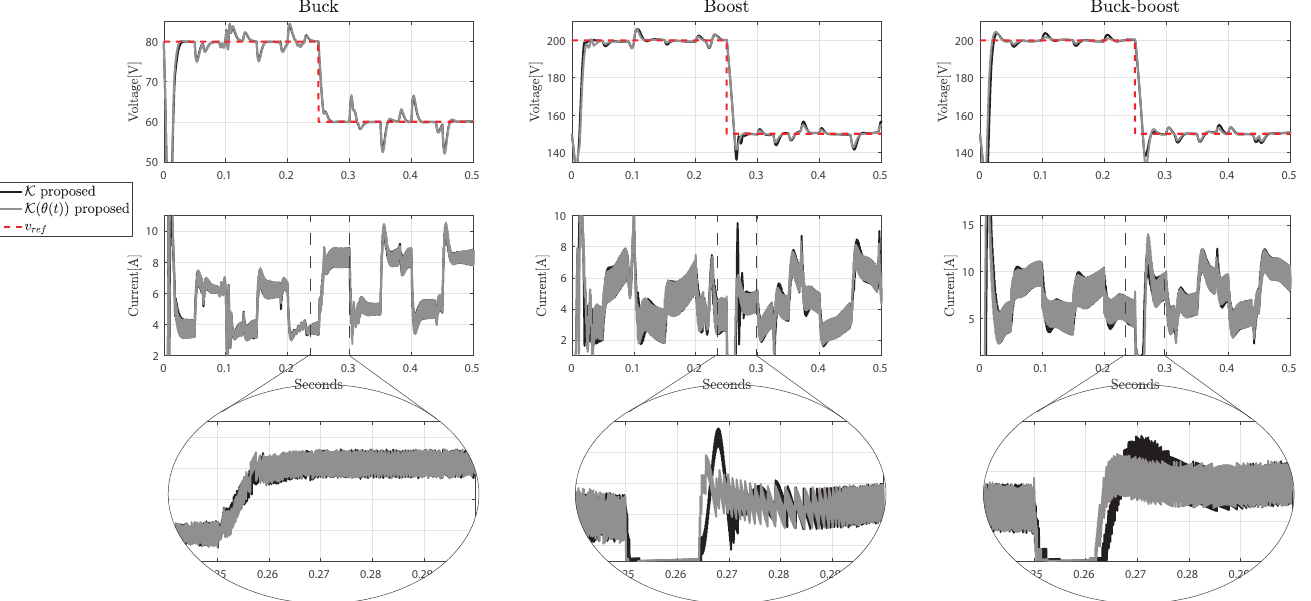
Figure 11. DC–DC converters state response for time-varying bounded case based on CLP problem assumed to vary according to: V in ( t ) = 100 + 20 sin ( 50 t ) V and P ( t ) as a square signal with amplitude ∈ [ 300 500 ] W and frequency of 10 Hz. The upper figures indicate the voltage and the setpoint on the three converters. The lower figures show the current obtained in the inductor. A zoom to the current plot is also